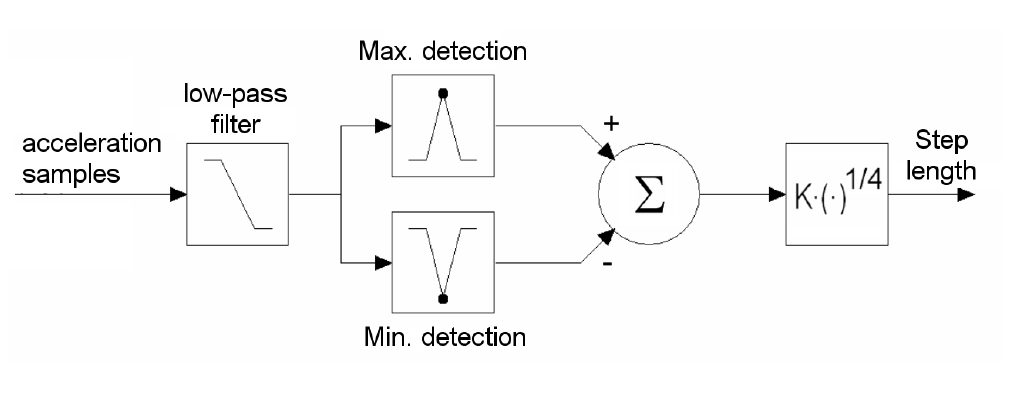
Figure 4. The algorithm for estimating the number of steps and their